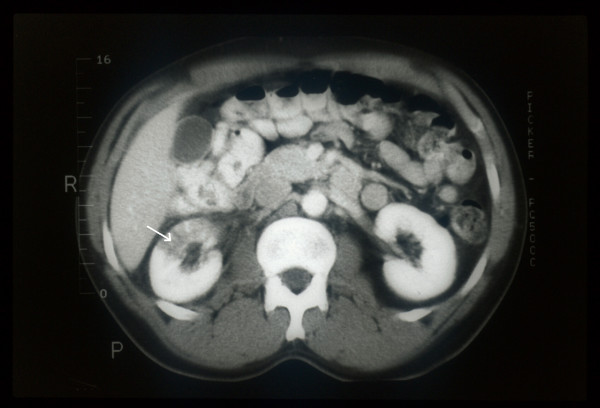
Computerized Tomography showing areas of focal decreased enhancement of the anterior lower poles (white arrow) of the right kidney suggesting renal infarction versus pyelonephritis.